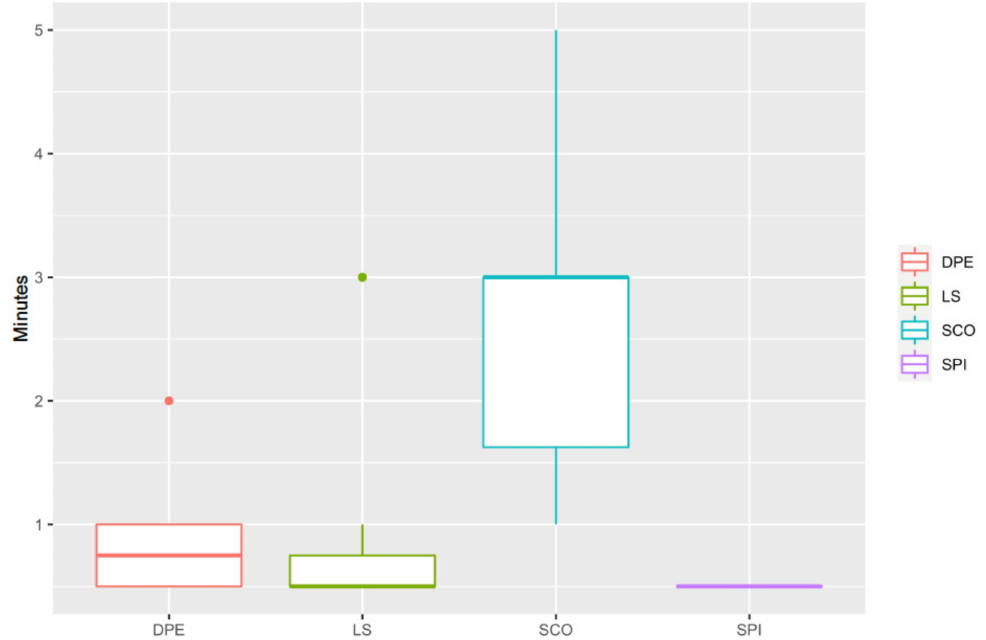
Figure 3. Time to the abolishing of the patellar ligament reflex or Westphal’s sign in minutes. DPE, dural puncture epidural injection; LS, epidural injection in the lumbosacral space; SCO, epidural injection in the sacrococcygeal space; SPI, injection in the subarachnoid space. SCO was significantly slower in blocking this reflex than the rest of the groups.